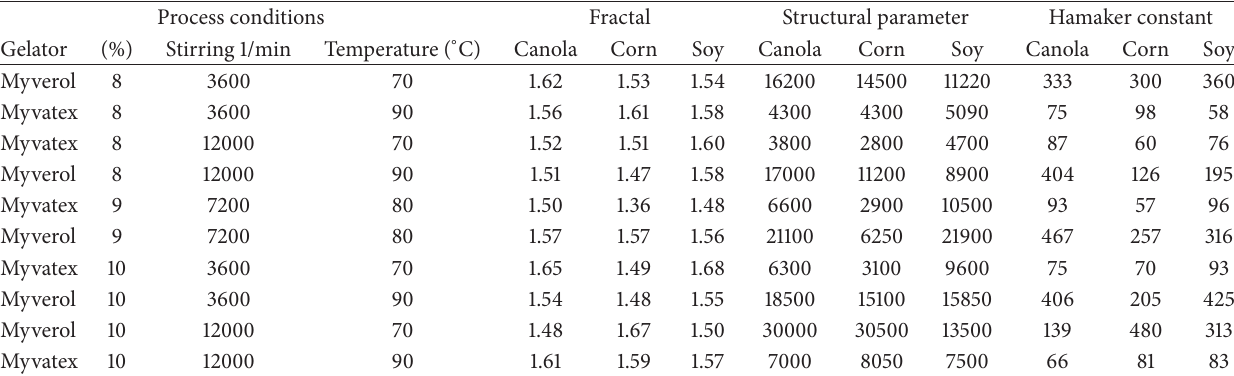
Table 3: Physical parameters of organogel